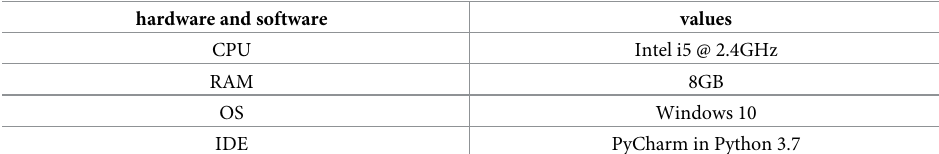
Table 2. Experimental environment.